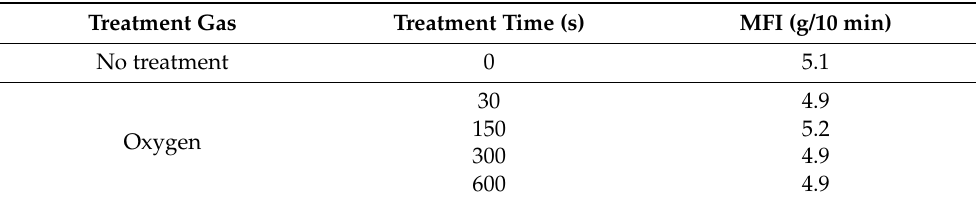
Table 2. Melt flow index (MFI) of selected batches in relation to the treatment time. Treatment